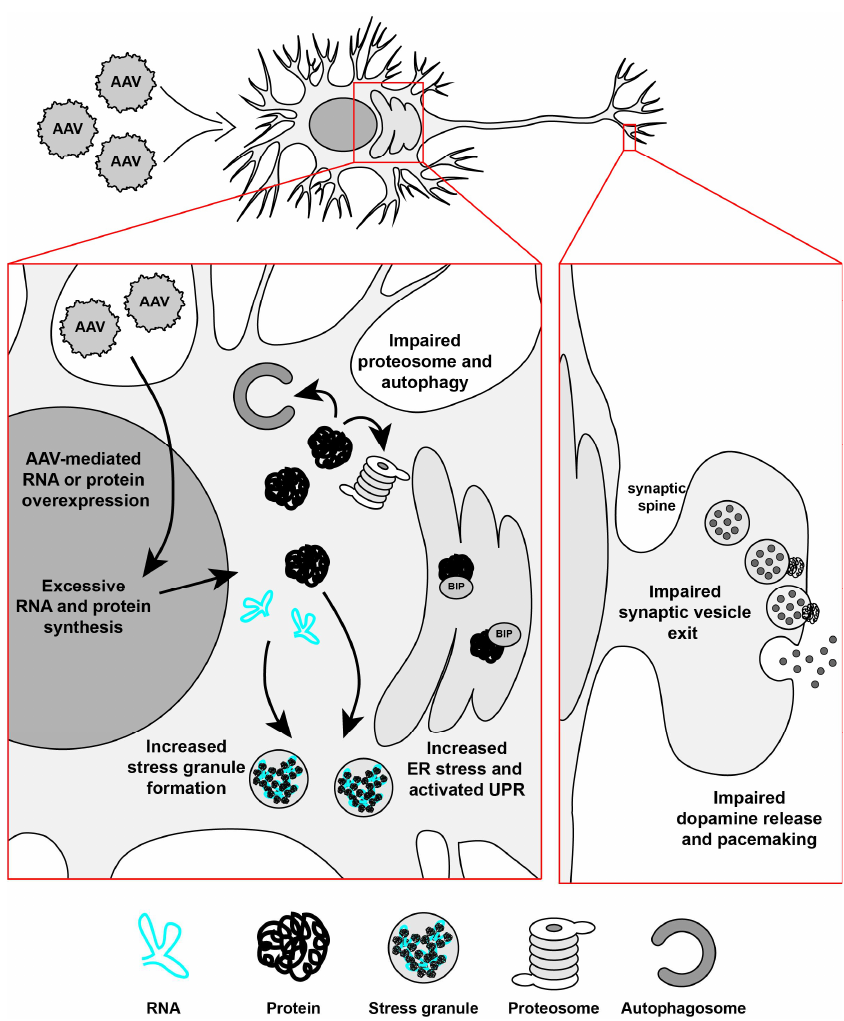
Figure 1. Schematic diagram of protein overexpression via AAV in the substantia nigra dopamine neurons. When an AAV carrying protein or RNA is expressed in the brain, particularly in the substantia nigra where dopamine neurons are vulnerable to stress, the consequences of excessive overexpression may result in a number of events detrimental to cell survival. These include the increased formation of stress granules, increased levels of endoplasmic reticulum (ER) stress, activation of the unfolded protein response (UPR), and impairment of the proteasome function and autophagy. This could further result in impairments in vesicle fusion at the synapse and difficulties in the dopamine release and pacemaking functions of the neuron. This would culminate in reduced neuronal activity and may result in the death of the neuron. (BIP: Binding immunoglobulin protein).